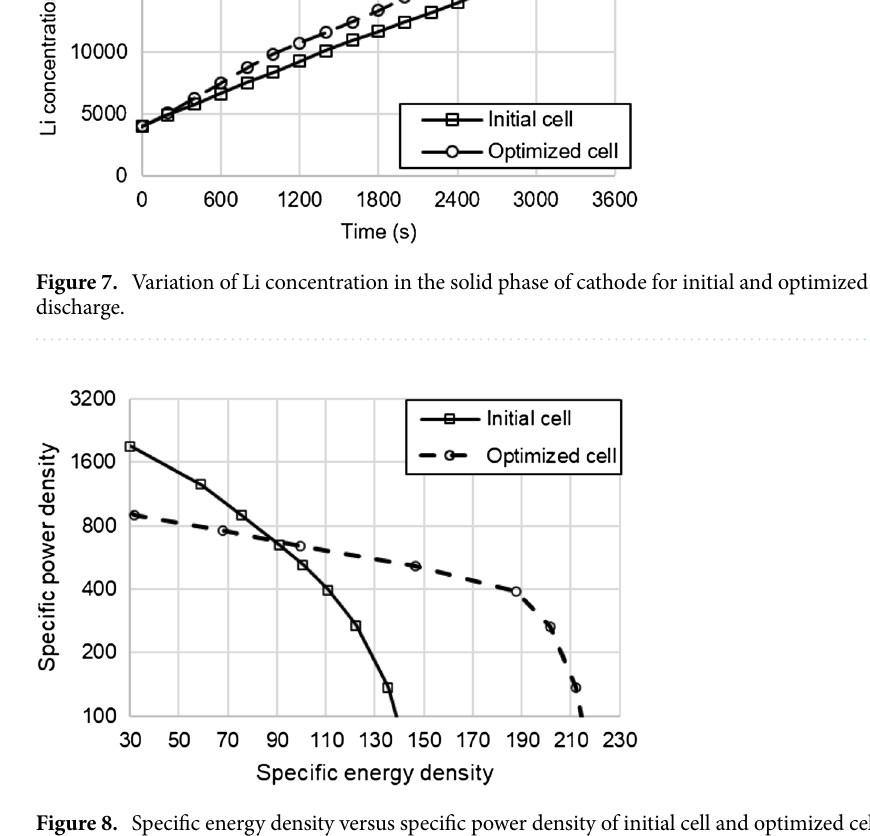
Figure 8 is a graph of specific energy density vs. specific power density of the initial and optimized cells. At a specific power density of 600 W/kg and below, the optimized cell showed a higher specific energy density per-